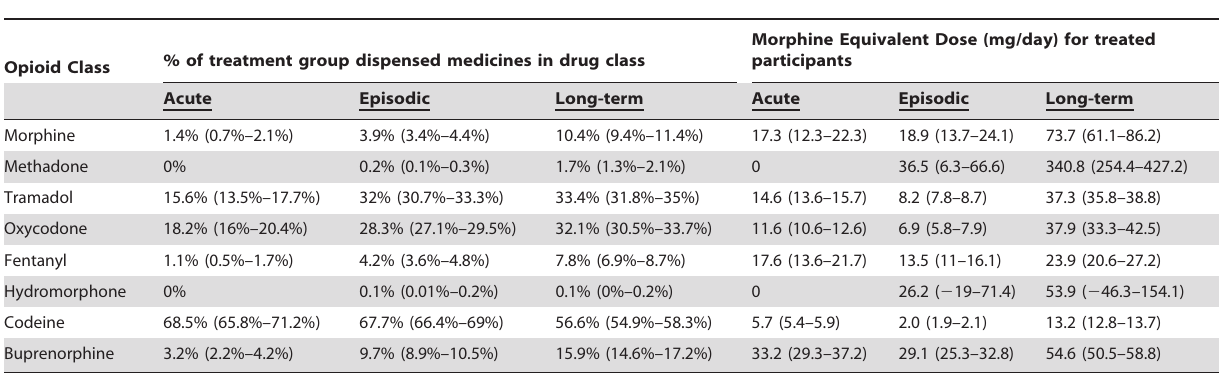
Table 3. Use of opioid analgesics by drug class and treatment group, with total morphine equivalent dose (/day across entire opioid supply period) for those dispensed type at least